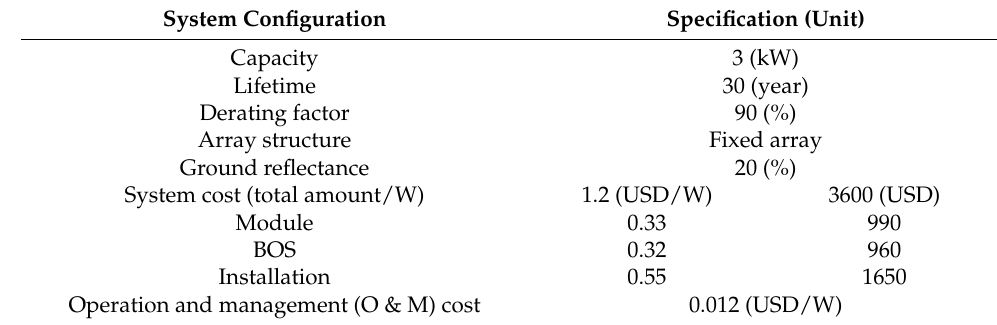
Table 5. Specifications of applicable PV system.